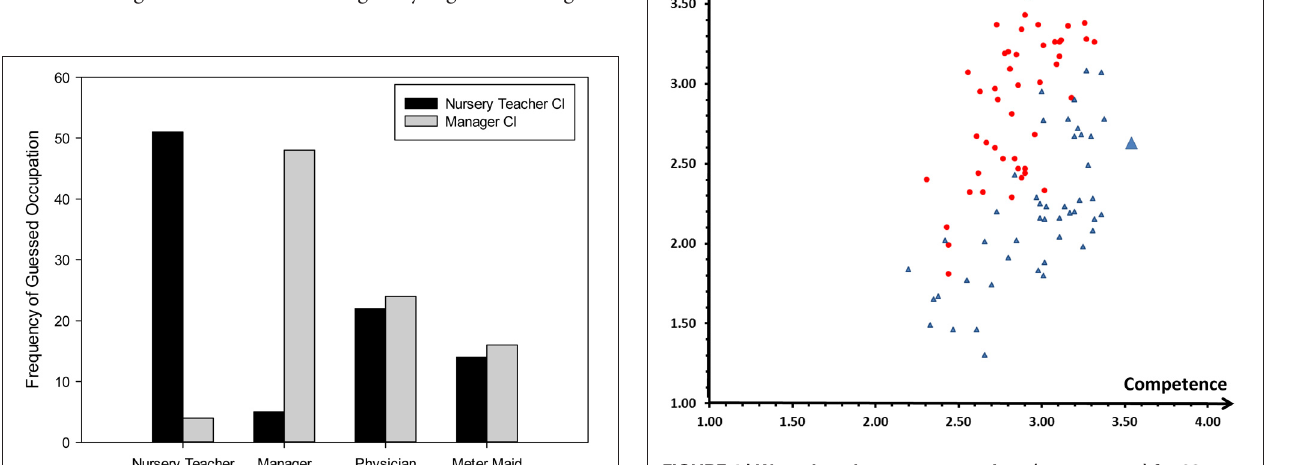
FIGURE 4 | Warmth and competence ratings (mean scores) for 92 individual classification images (small symbols) and two group-wise images (large